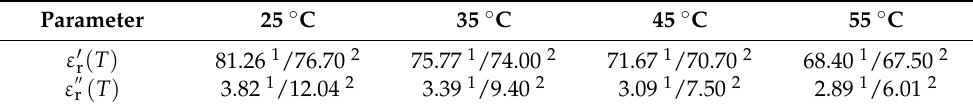
Table 1. Complex relative permittivity ε r = ε (cid:48) r − j ε (cid:48)(cid:48) r of pure water at 915 MHz [15] or 2.45 GHz [16] as a function of